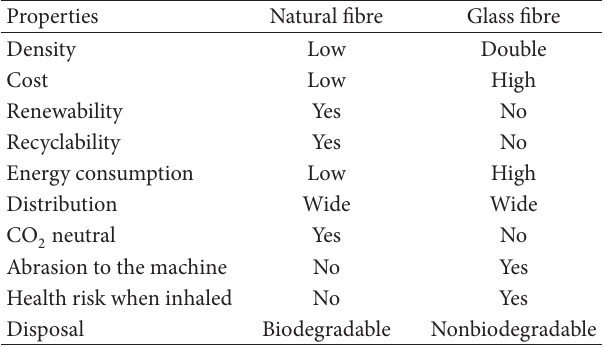
Table 4: Comparison between glass fibre and natural fibres